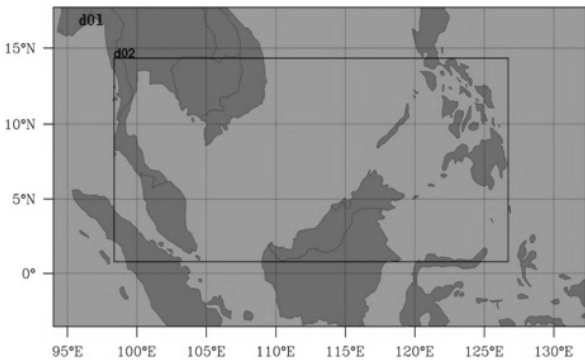
Figure 2. Model domains.